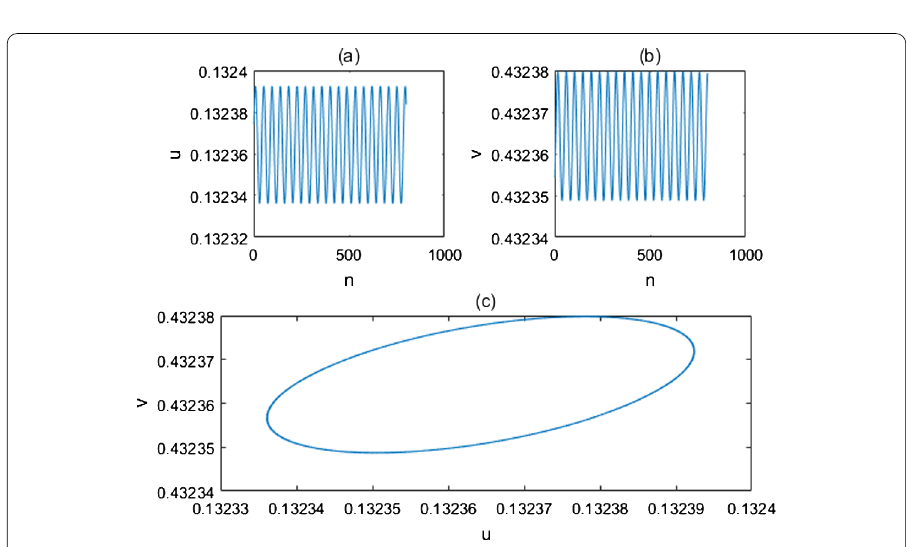
α = –0.3861031954. By Theorem 3.1, a Neimark–Sacker bifurcation emerges from E